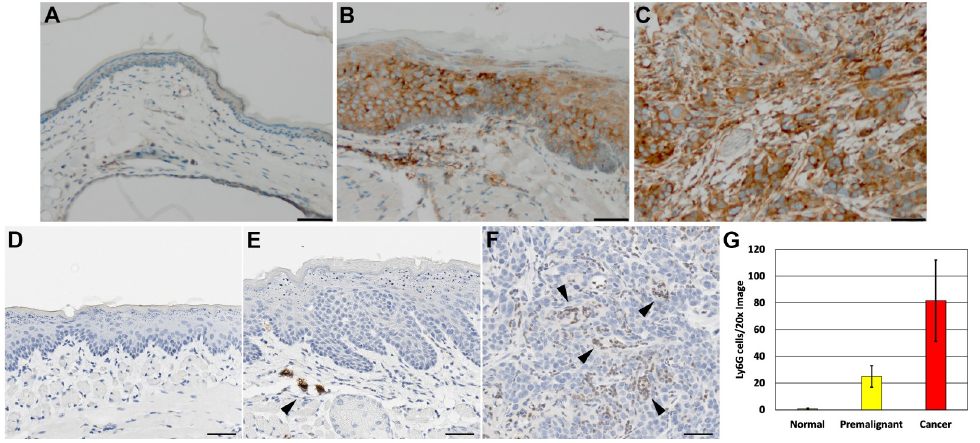
Fig 3. Increased NFkB and immune cell presence in DBPDE-induced mice. (A) Normal oral epithelium in DBPDE treated mice are negative or weakly positive for total p65 NFkB protein levels as measured by IHC staining. (B) A representative image of a dysplastic epithelium from DBPDE-treated mice that has increased NFkB staining. (C) NFkB staining is increased in invasive cancers of DBPDE-treated mice. Ly6G was used as a marker for MDSCs, primarily of the neutrophil precursor lineage. (D) Normal oral epithelia do not have a significant presence of Ly6G positive cells. (E) DBPDE-induced dysplasia and (F) invasive cancers do have an increased number of Ly6G-positive cells suggesting a role for MDSCs in tumor development in DBPDE treated mice. Scale bar = 50uM. n = 15. (G) Quantification of Ly6G recruitment measured by counting Ly6G cells/20x image (n = 3).